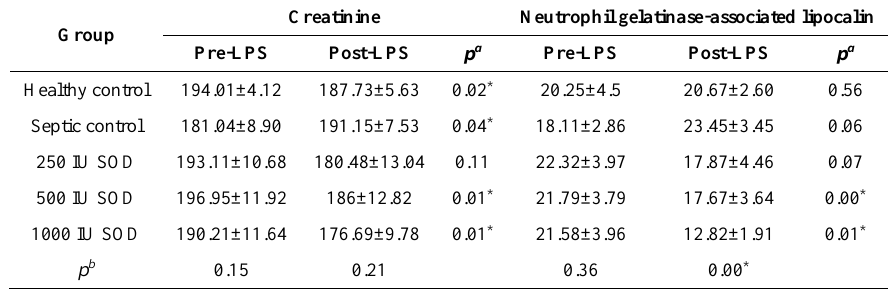
Superoxide dismutase Reactive oxygen species